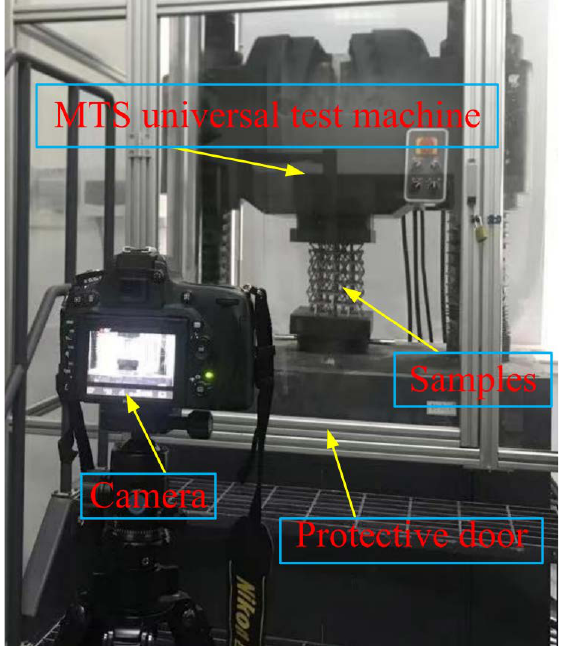
Figure 6. MTS universal testing machine.